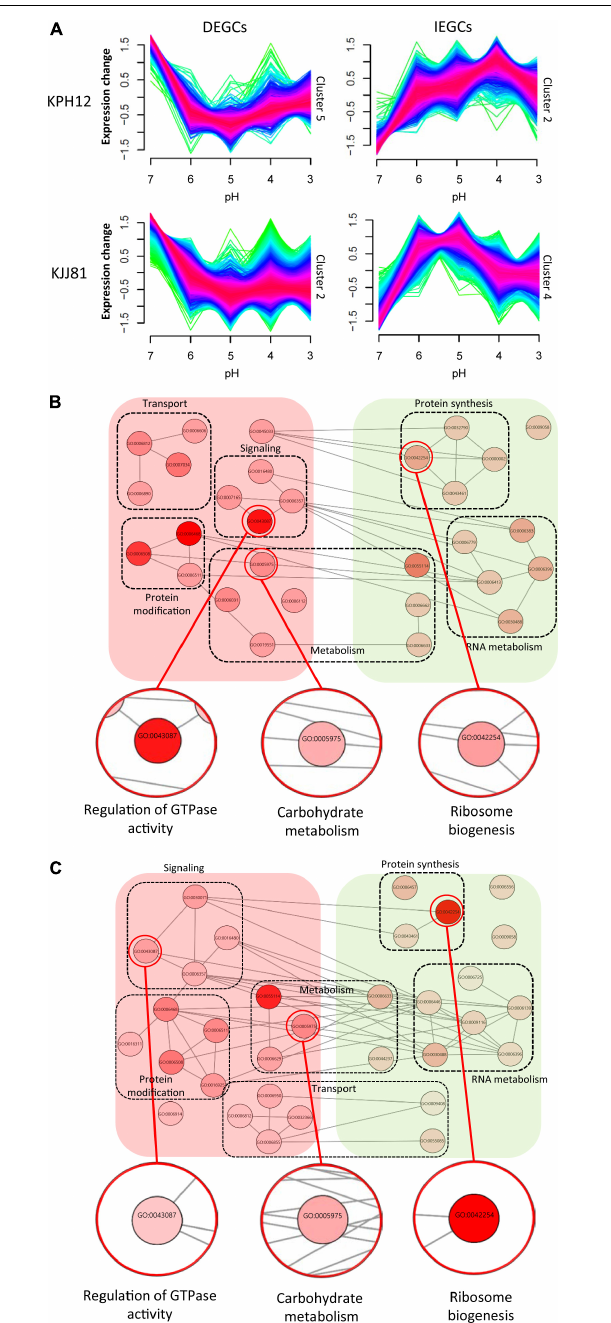
FIGURE 7 | Fuzzy c-means clustering identifies general gene expression patterns of Saccharomycopsis fibuligera . (A) Clusters of DEGCs and IEGCs of KPH12 and KJJ81 strains at pH values from 7 to 3. Among the five gene clusters classified by fuzzy c-means, two clusters that showed extreme upregulation and downregulation at pH 6 were selected. The membership of a given gene within a cluster is represented by color, with red indicating high association. (B,C) For each cluster, enriched biological processes were identified, and only those belonging to the chosen clusters were visualized based on REVIGO. Nodes represent the terms, and edges represent the strength of the terms pairwise similarity. Significance is represented by node color. DEGCs, decreasingly expressed gene clusters; IEGCs, increasingly expressed gene